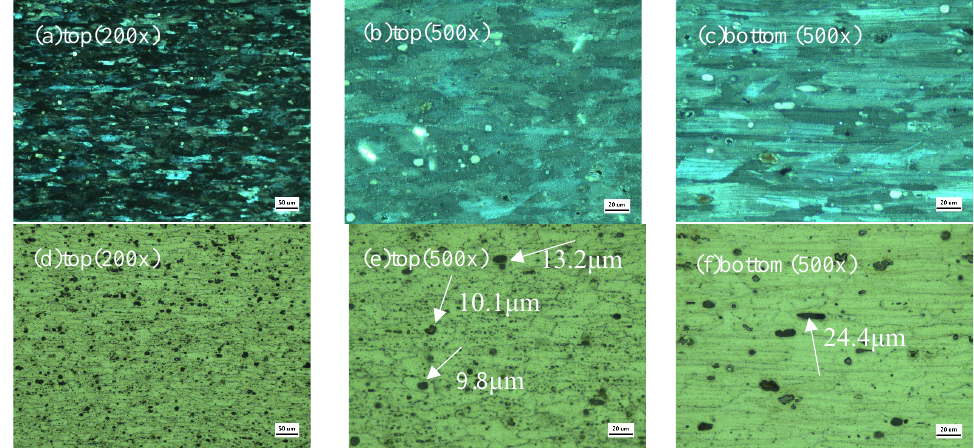
Figure 12. Metallograph of synchronous water-cooling: ( a – c ) under polarized light; ( d – f ) bright field. Without SWC, the grain size increased significantly in the thickness direction (Figure